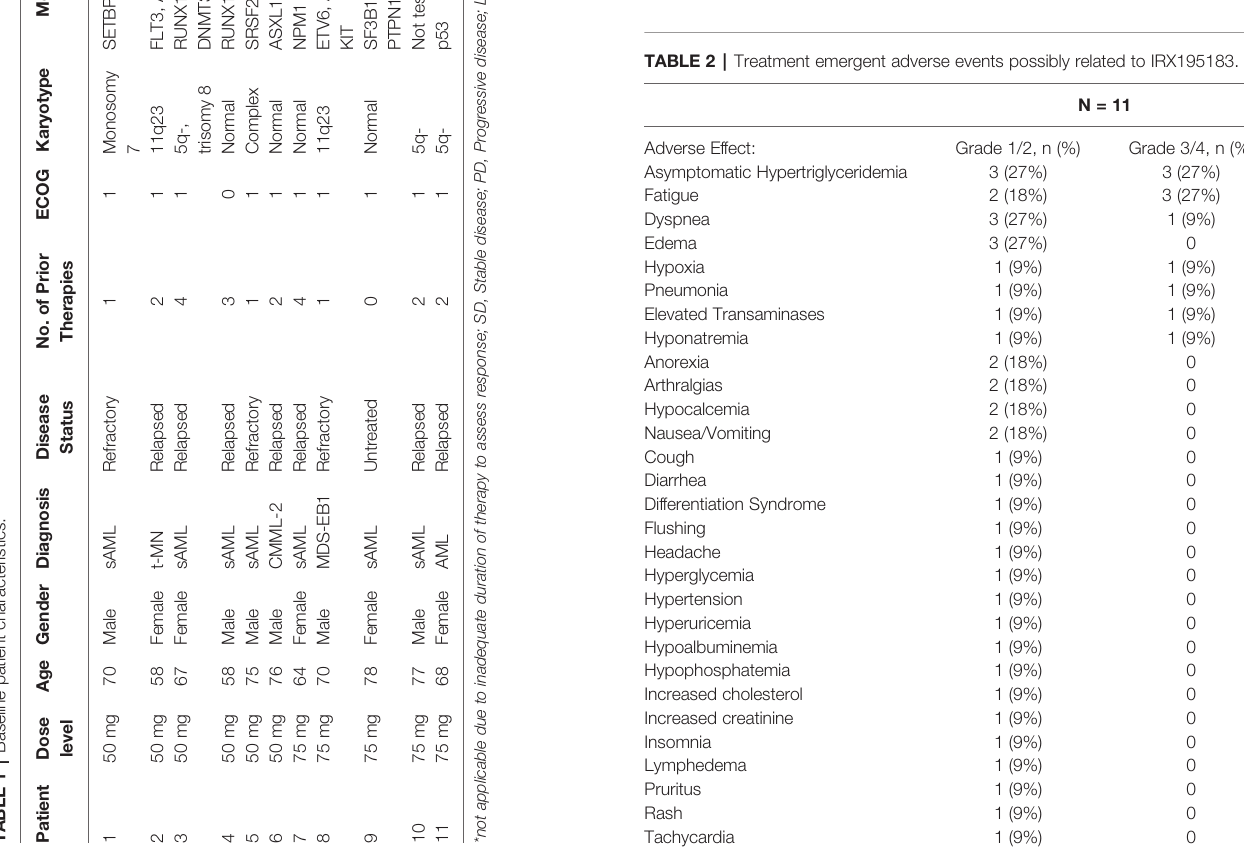
Table 2 summarizes the treatment-emergent adverse events at least possibly related to IRX195183. A total of six patients developed hypertriglyceridemia. Three patients had Grades 1 – 2 hypertriglyceridemia and three had Grades 3 – 4 hypertriglyceridemia. Five of the six patients were treated with lipid modifying therapies including gem fi brozil and omega-3-acid ethyl esters. Once initiated, lipid modifying therapies were continued until the study drug was discontinued. For all three patients with Grade 3 hypertriglyceridemia, the study drug was held until the hypertriglyceridemia improved. One patient was able to resume therapy after initiation of after initiating lipid modifying therapy, whereas hypertriglyceridemia led to permanent discontinuation of the study drug in the remaining two patients. All three patients who experienced grade 3 hypertriglyceridemia were treated at the fi rst dose level, whereas none of the patients treated at the second dose level developed Grades 3 – 4 hypertriglyceridemia. All six patients with hypertriglyceridemia were asymptomatic and none suffered adverse consequences such as hepatosplenomegaly, acute pancreatitis, dyspnea, or neurological symptoms. There were no other DLTs and no other patients discontinued the study due to study drug-related adverse events. Patient 2 developed Grade 3 elevations of her transaminases in the setting of hospitalization, but they returned to normal levels without discontinuation of the study drug. Two patients developed leukocytosis (>10,000/cc mm) for which hydroxyurea was initiated. Another patient, Patient 2, developed Grade 3